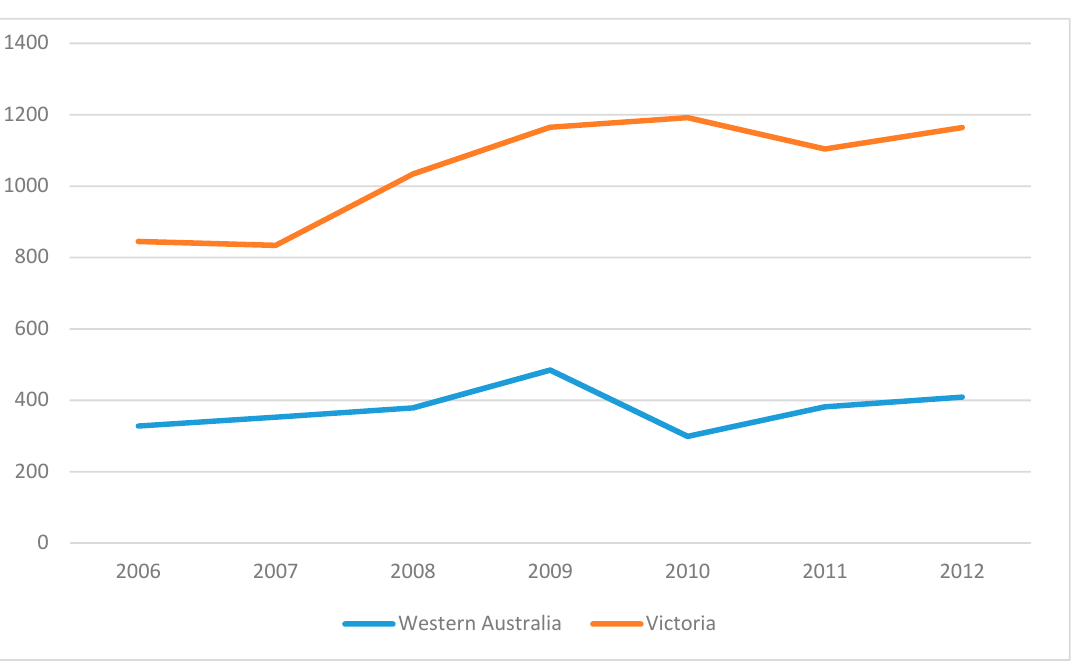
Figure 2. Physical abuse reports: Western Australia and Victoria 2006–2012 (rate/100,000 children).